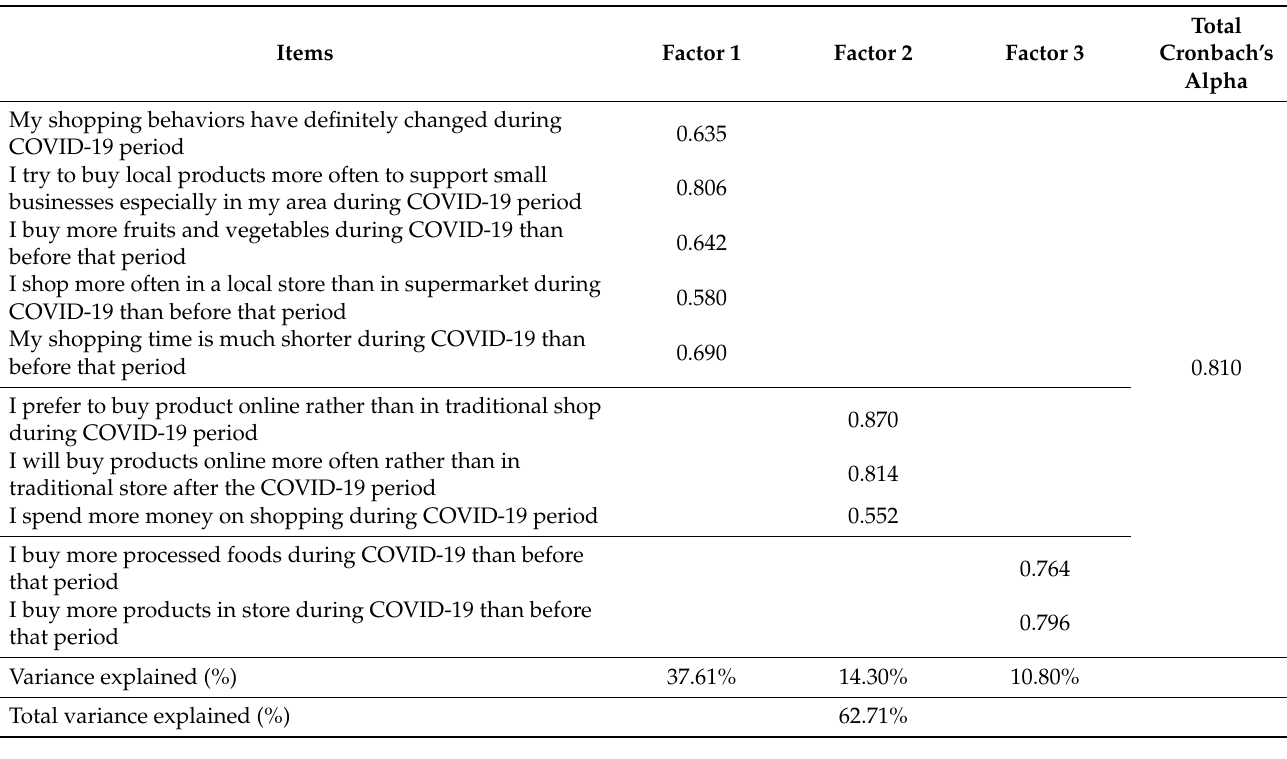
Table 4. The results of EFA: Asian students.